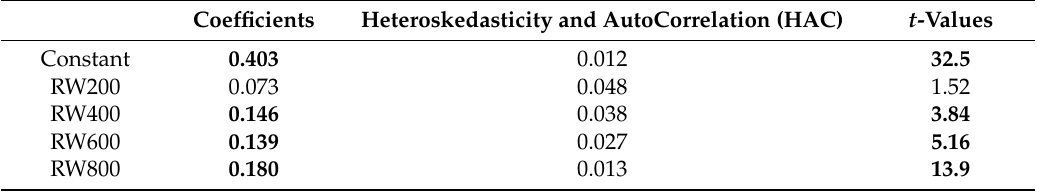
Table 9. Ordinary Least Squares (OLS) estimates from Equation (2) (bold denotes